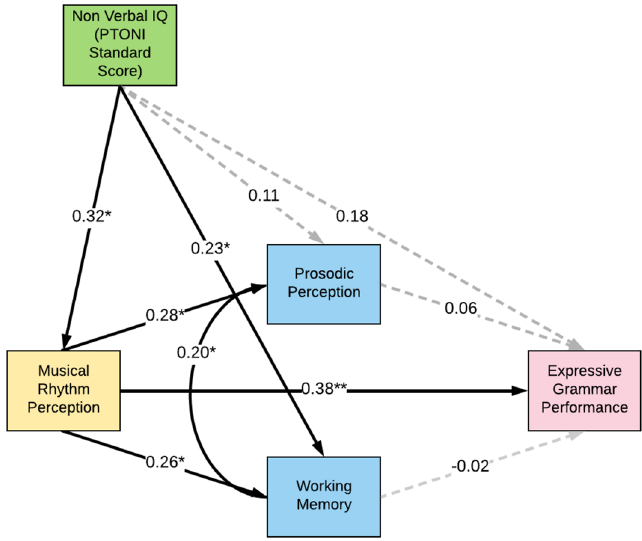
Figure 4. Path analysis model for musical rhythm perception and expressive grammar, controlling for non- verbal IQ. This figure depicts the path model for music rhythm perception and expressive grammar, prosodic perception and working memory as mediators, with IQ as a covariate ( n = 103). Age was partialled out from all variables (except IQ), by creating z-scored residualised scores of age against the z-scored, raw scores of variables. Z-scored standard PTONI scores were used as the measure of IQ. Missing values were excluded in a list-wise fashion. The β for each pair of variables is indicated on the path. Solid lines indicate a significant relationship.*signifies p < 0.05, while **signifies p <